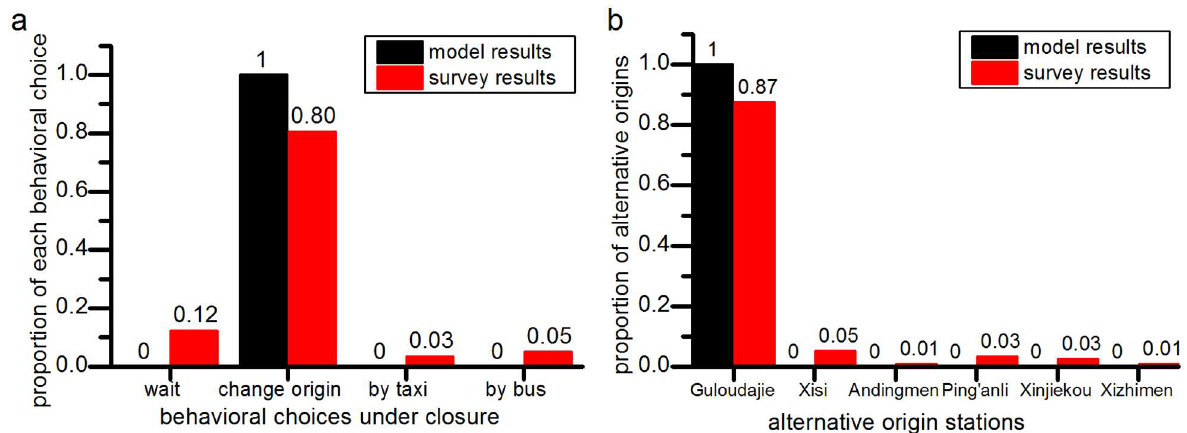
Fig 24. The comparisons of the model outputs and the manual surveysin the JISHUITAN closure case. In the manual survey, 80% (119 of 148) of passengerschoose to alter their plannedorigin station (Fig 24(a)) and 87% (104 amongthe 119) passengers choose the GULOUDAJIE as their new origin station (Fig 24(b)). But our model results show that all the affected passengers will change their origins and choose the GULOUDAJIE station as their new origins, which indicatesthat there is an error of no more than 20% betweenthe model results and the actual survey